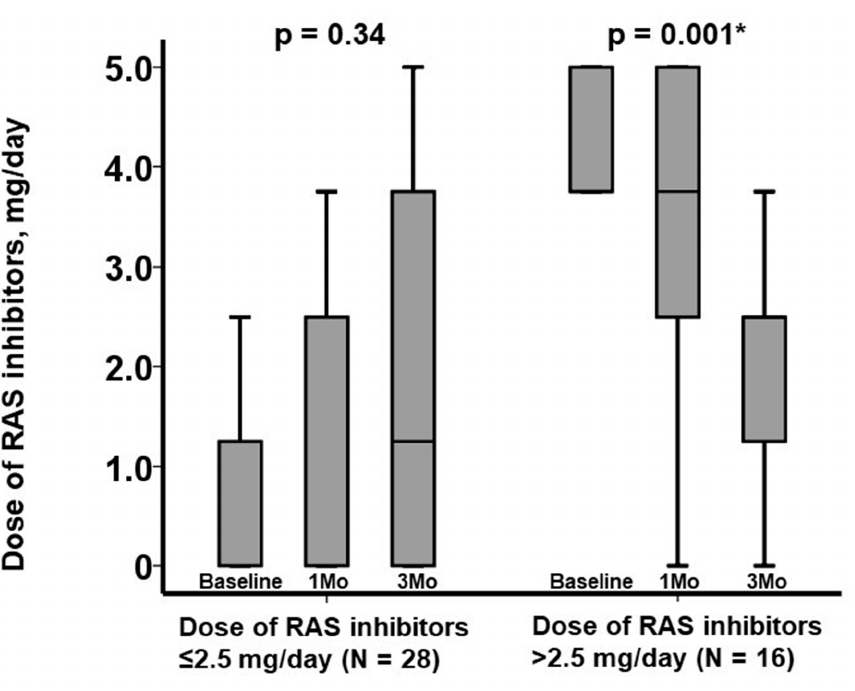
Figure 3. Three-month trends of dose of RAS inhibitors stratified by the cutoff of baseline dose of RAS inhibitors. Trends were assessed by using Friedman test. *p <0.05.